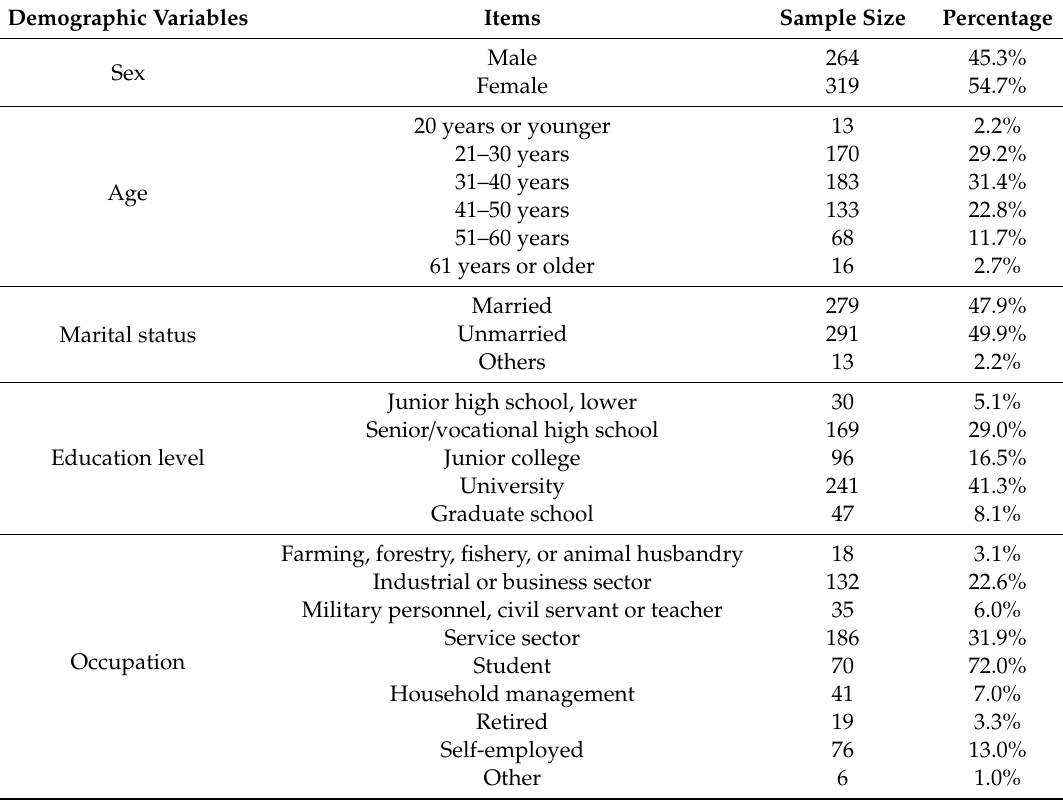
Table 2. Demographics of participants queuing at a